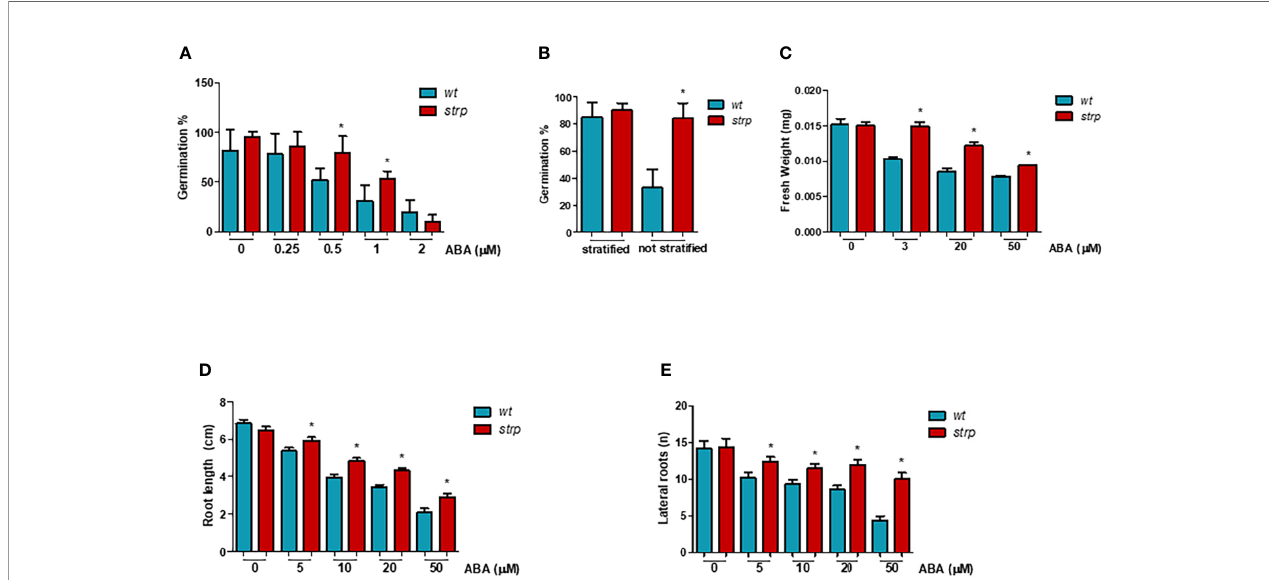
FIGURE 8 | The strp mutant has an ABA-hyposensitive phenotype. (A) germination rate of strp and wild type seeds, assessed on seeds sowed on MS supplemented with 0.25, 0.5, 1, and 2 µM ABA, strati fi ed and transferred for one week in the growth chamber. (B) germination after strati fi cation or not, determined on 200 wild type and strp seeds after one week from sowing on MS. (C) plant growth rate on ABA, analysed on strp and wild type seedlings sowed on MS and transferred after 4 days on MS supplemented with 3, 20, and 50 µM ABA, and grown for additional two weeks. About 50 seedlings for each ABA concentration were used. (D, E) primary root elongation and lateral roots formation, assessed on wild type and strp plants germinated on MS and transferred after 4 days on the same medium supplemented with 5, 10, 20, and 50 µM ABA and grown for one additional week. Error bars are S.E.M. of three independent experiments. *P < 0.01, by Student ’ s t-test.